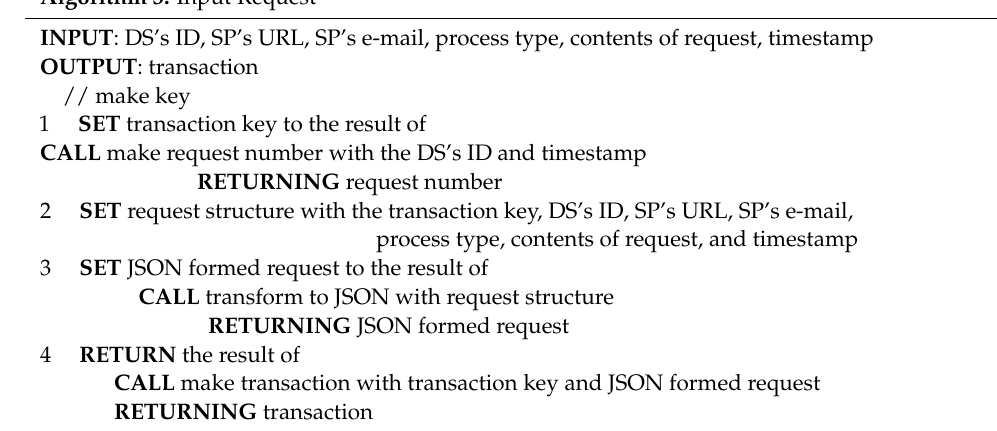
Algorithm 3. Input Request